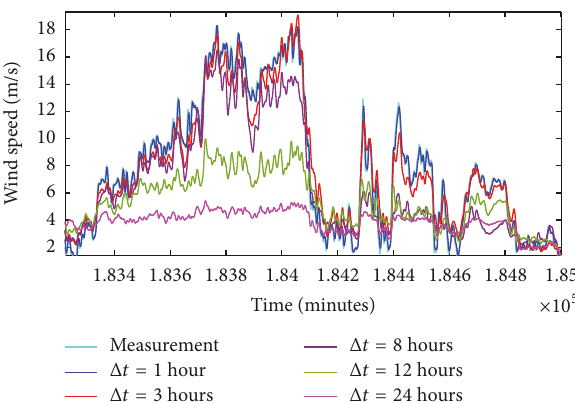
Figure 7: Comparison of the measured wind speed and model response (five minutes’ time step) in process of the model evaluation according to time prediction steps ( Δ𝑡 = 1 h, Δ𝑡 = 3 h, Δ𝑡 = 8 h, Δ𝑡 = 12 h, and Δ𝑡 = 24